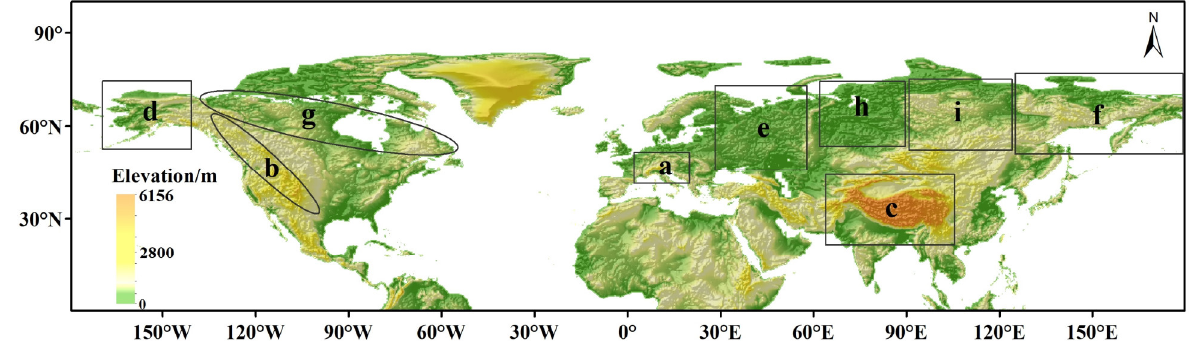
Figure 1. Locations of ( a ) the Alps, ( b ) the Rocky Mountains, ( c ) the Qinghai–Tibet Plateau, ( d ) Alaska, ( e ) the Eastern European Plain, ( f ) the Eastern Siberian Mountains, ( g ) Northern Canada, ( h ) the West Siberian Plain, and ( i ) the Central Siberian Plateau in the NH.